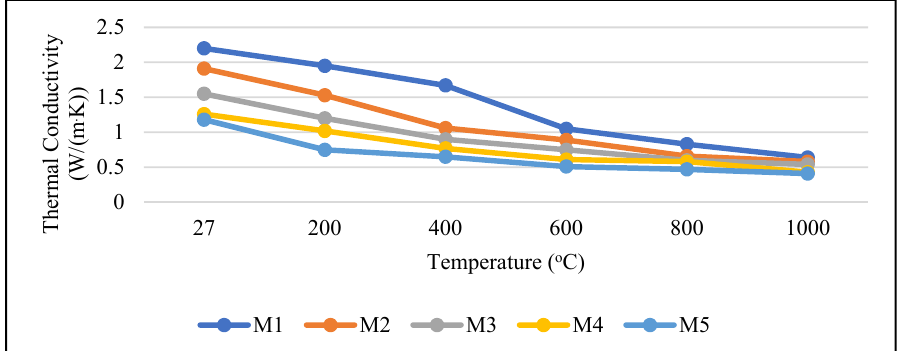
Figure 14. Thermal conductivity of mortar mixes under different temperatures.